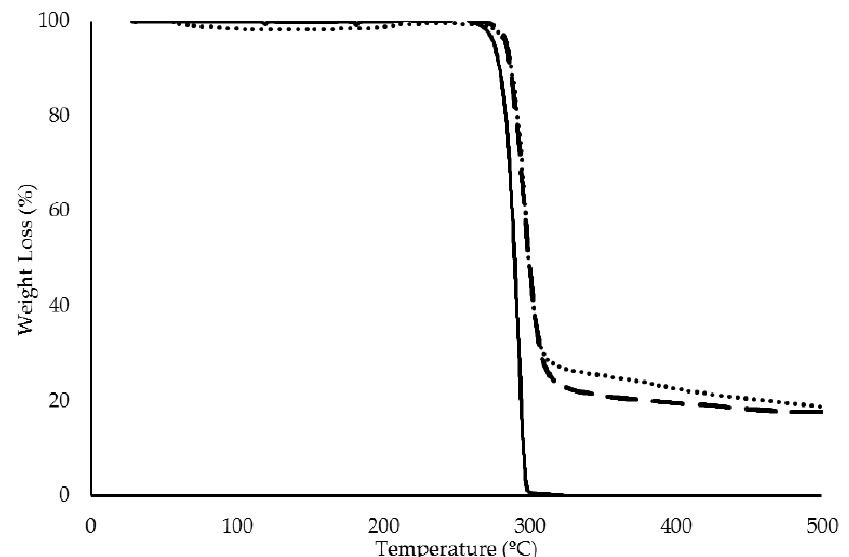
Figure 3. Thermogravimetric analysis (TGA) curves of pure P(3HB) (straight line - ) and mcl-PHA (dotted line ··· ) produced by C. necator DSM 428 and P. citronellolis NRRL B-2504, respectively, and of their blend (dashed line — ) isolated from the cultivation in apple pulp waste.